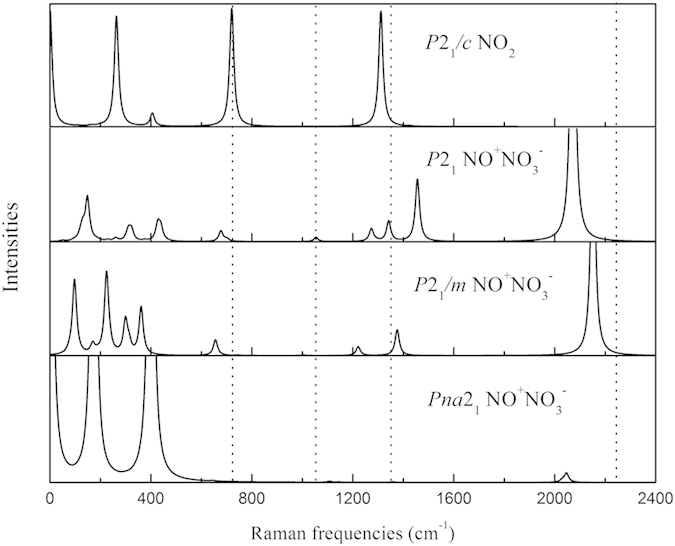
Simulated Raman spectra of P21/c NO2, and P21, P21/m20 and Pna2116 NO+NO3− at 20 GPa.Typical Raman frequencies of NO+ and NO3− in experiment17 were drawn by dotted lines.